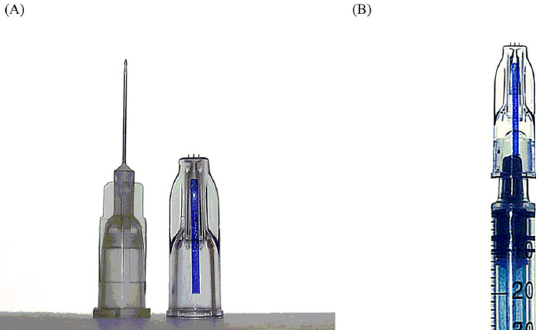
Fig 2. MicronJet600 compared to the 27 G hypodermic needle (A), and MicronJet600 placed on 1 mL syringe (B).